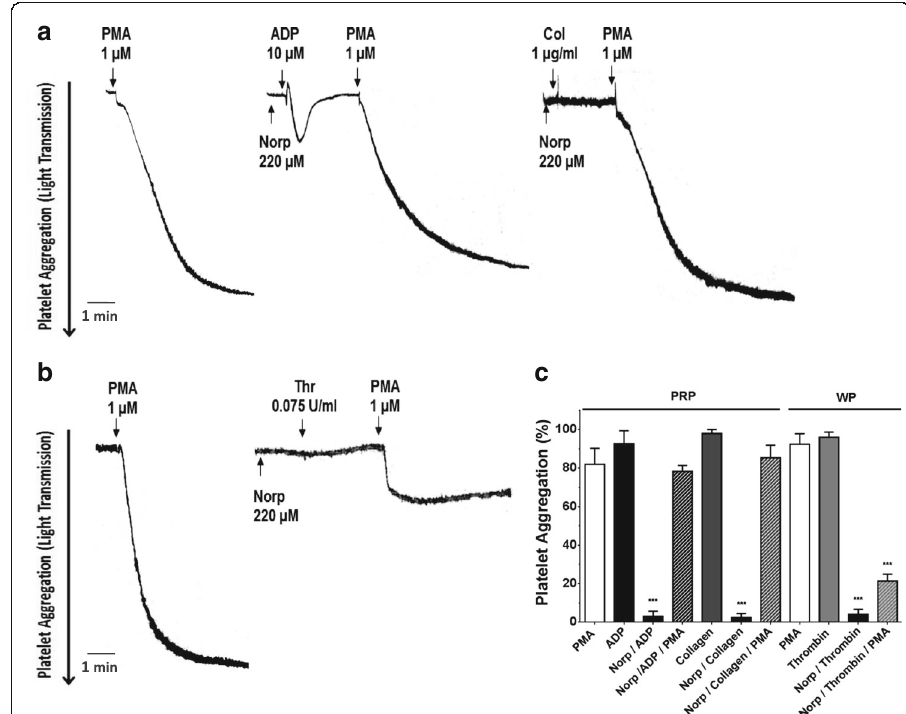
Fig. 6 PKC activation reversed the inhibition of norpurpureine on agonist-stimulated platelet aggregation. Typical traces of platelet aggregation monitored by changes in the light transmission signal over time are shown in a platelet-rich plasma (PRP) and b washed platelets (WP). Platelets were exposed to norpurpureine inhibitory action for 10 min, then challenged with ADP and collagen (Col) or thrombin (Thr) followed by PMA, as indicated. PMA (control) in each platelet preparation is shown. These original tracings are representative of three experiments done independently for each agonist. Quantification of the data in ( a ) and ( b ) are shown in ( c ). Each data point is the mean±SD ( n =3), p <0.001(***) vs. PMA in each platelet